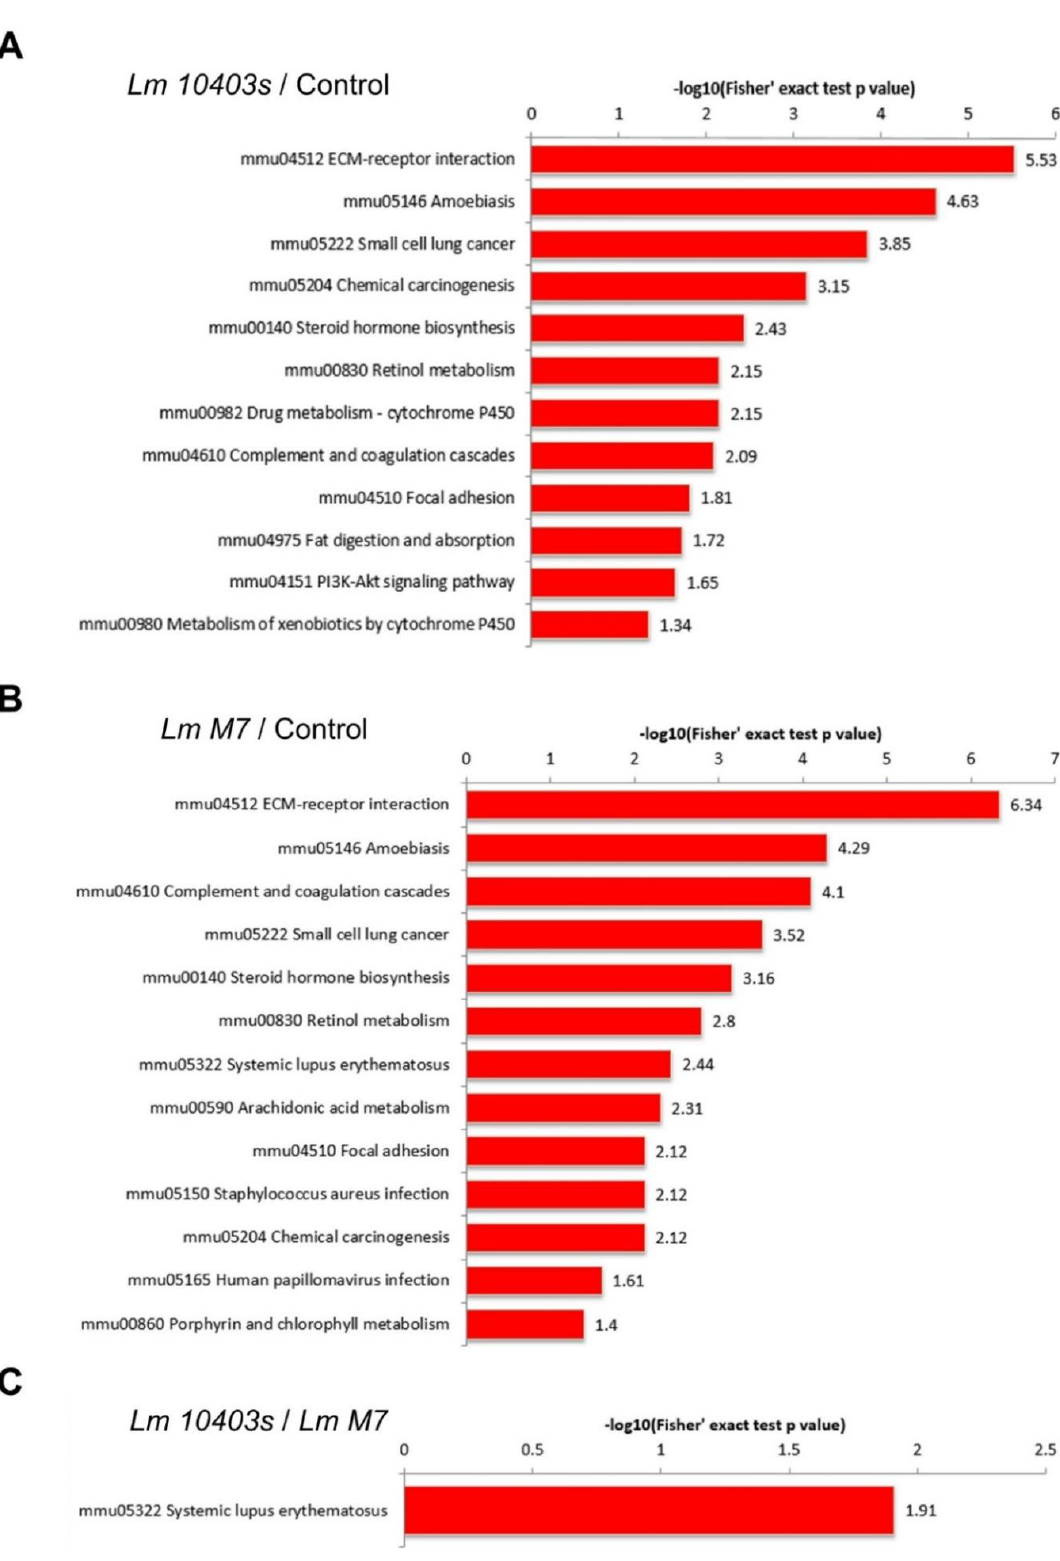
Figure 7. KEGG enrichment analysis of the DEPs. ( A ) Significantly enriched KEGG terms of the DEPs in the Lm 10403s vs. control comparison. ( B ) Significantly enriched KEGG terms of the DEPs in the Lm M7 vs. control comparison. ( C ) Significantly enriched KEGG terms of the DEPs in the Lm 10403s vs. Lm M7 comparison.